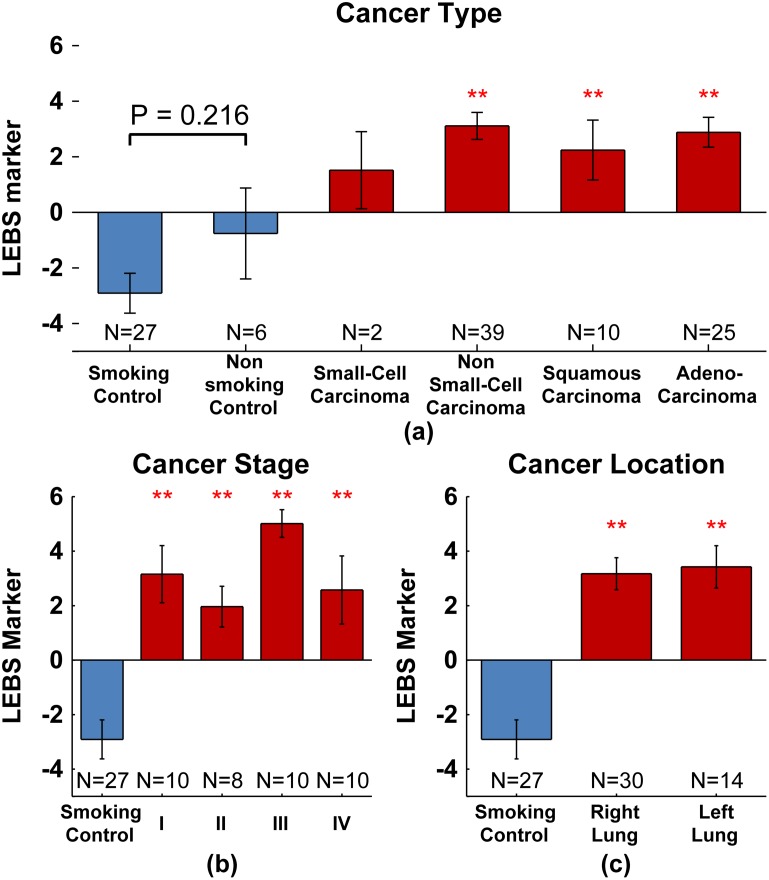
LEBS marker by cancer type, stage, and location.Composite LEBS marker separated according to cancer type (panel a), stage (panel b), and location (panel c). The double red star indicates statistical significance at the 0.1% level. In each panel, a number of cancer patients were not added to the subgroups due to incomplete pathology reports.